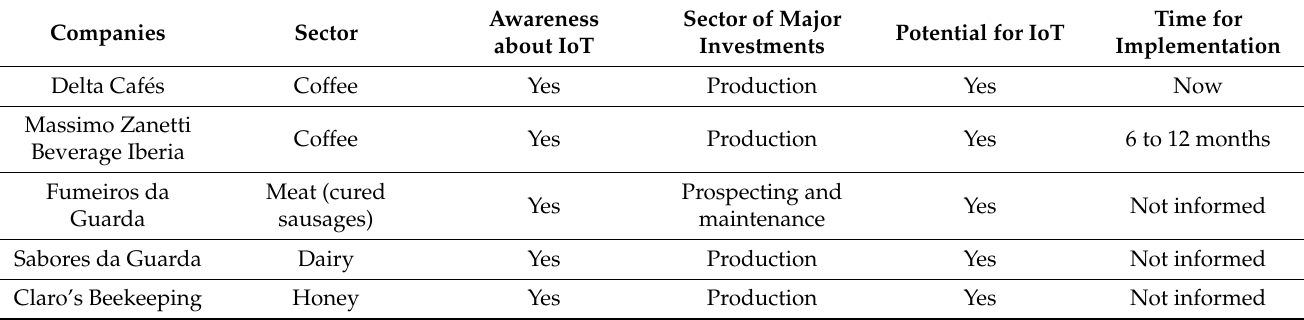
Table 6. Main features of agro-food companies of